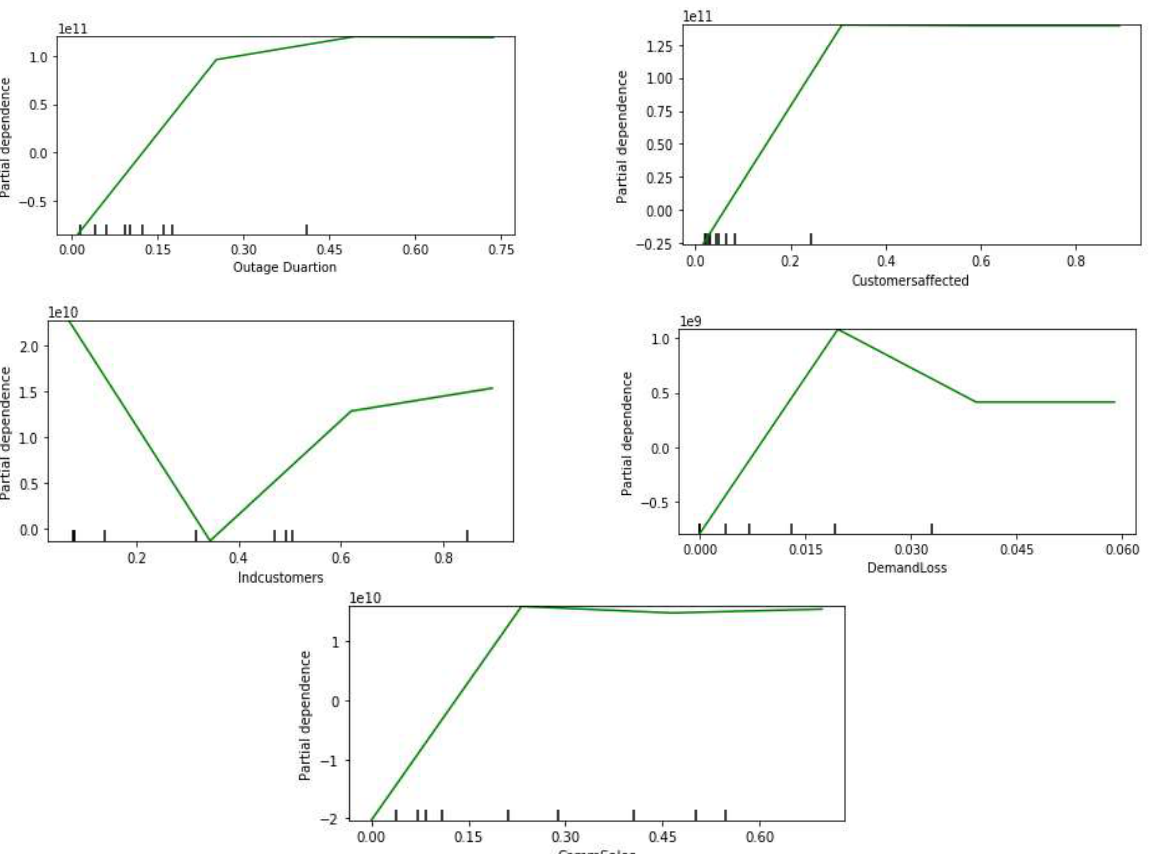
Figure 23. Top feature correlation plots for the storm disaster category. The individual partial dependence plots for the top five influential features for the electric power-related revenue loss due to storms are shown in Figure 24. The PDP of the industrial customers is different towards the revenue loss, while the rest of the PDPs show a similar pattern.